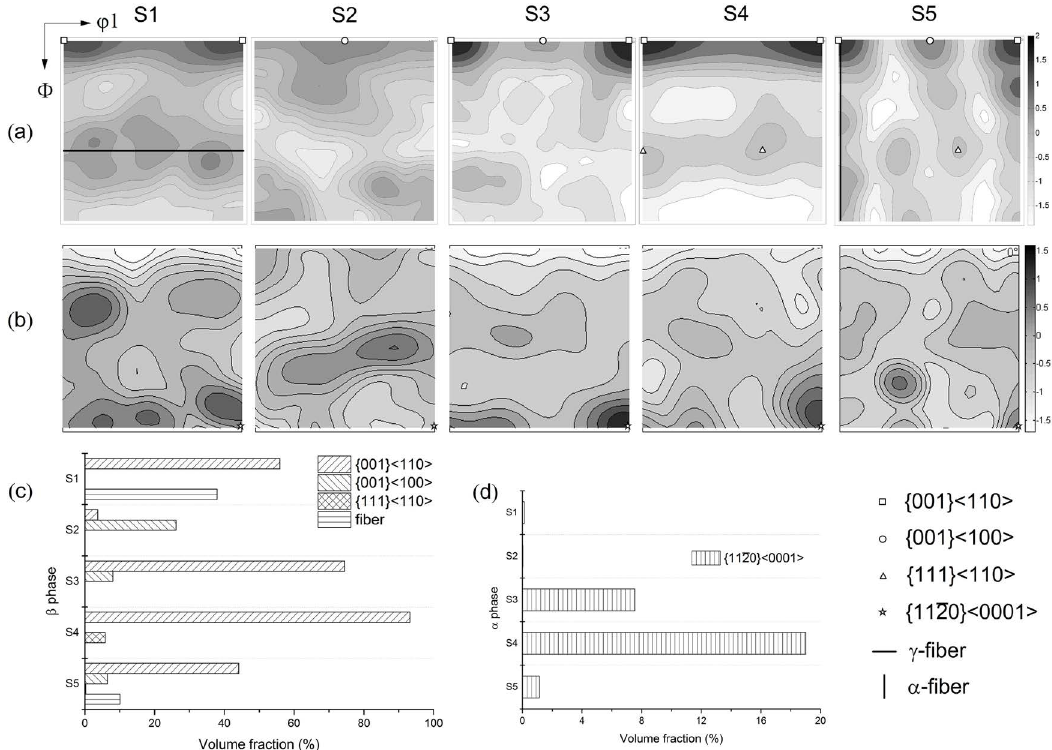
Figure 5. ODF section at φ2 = 45º for the β phase (a) and section at φ2 = 0º for the α phase (b) represented by the color bar with the logarithmic scale in multiples of random distribution. The calculated volume fractions of different texture components for the β phase (c) and for the α phase